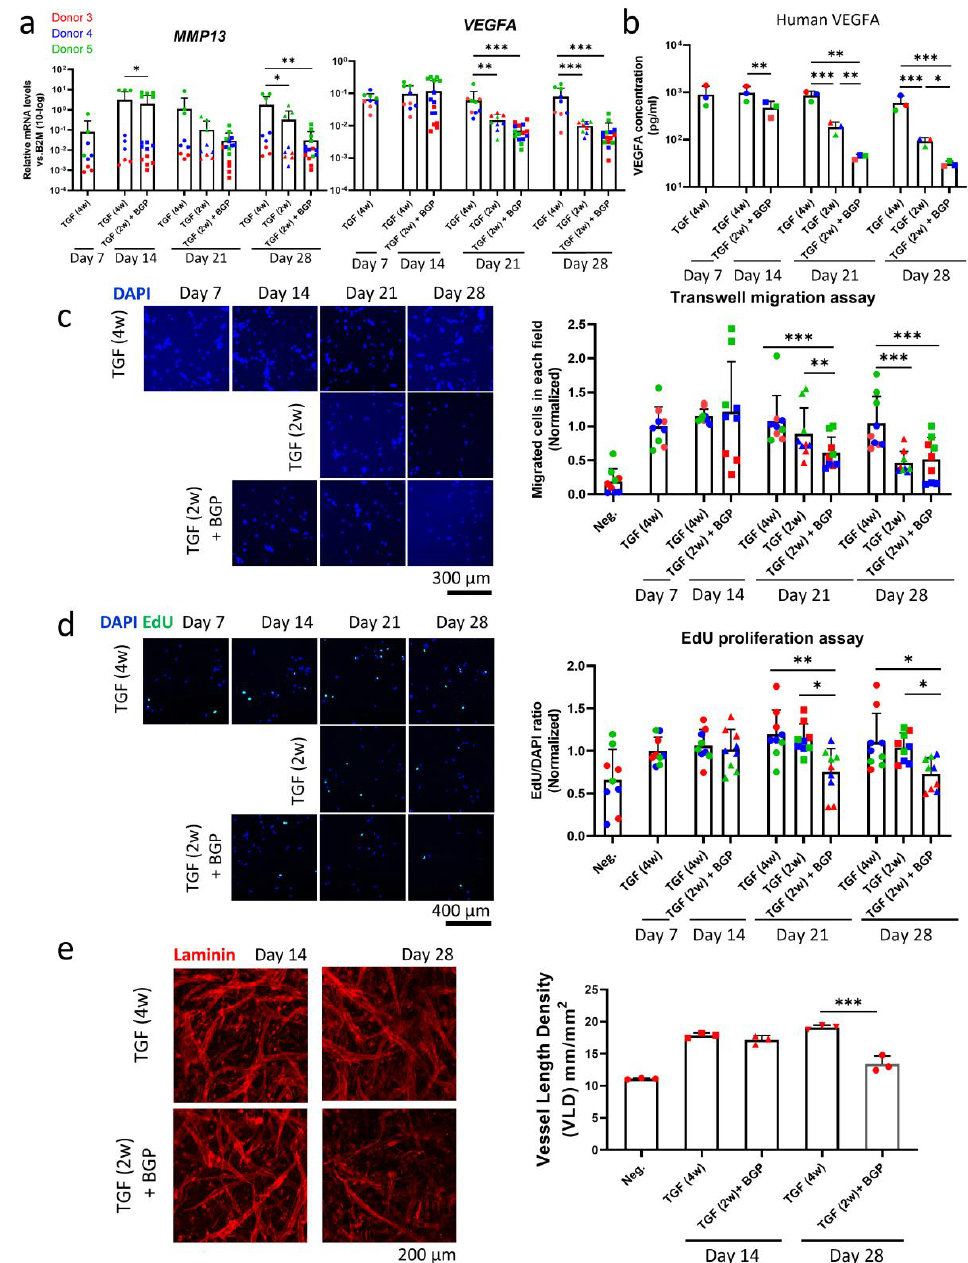
Figure 4. Assessment of the angiogenic potential of in vitro mineralised pellets. ( a ) MMP13 and VEGFA mRNA expression was determined by qRT-PCR. B2M was used as the housekeeper gene (N = 3 hMSC donors). ( b ) ELISA-based quantification of secreted VEGFA in the CM of chondrogenic and mineralised pellets over time (N = 3 hMSC donors). ( c ) Transwell migration assay performed with HUVECs exposed to the CM of the pellets. Representative images of migrated cells are shown. The graph displays the normalised number of migrated cells per field (vs. TGF (4w) day 7) (N = 3 hMSC donors). ( d ) dEdU proliferation assay performed with HUVECs exposed to the CM of the pellets. The graph displays the normalised EdU-positive cells per field (vs. TGF (4w) day 7) (N = 3 hMSC donors). ( e ) 3D tube formation assay in fibrin hydrogel performed using the CM from chondrogenic (TGF (4w)) and mineralised (TGF (2w) + BGP) groups from donor 3. Representative z-stack images obtained by confocal microscopy are shown. The graph displays the average VLD values per condition. All data are presented as average ± SD. * 0.01 < p < 0.05, ** 0.001 < p < 0.01, *** p <